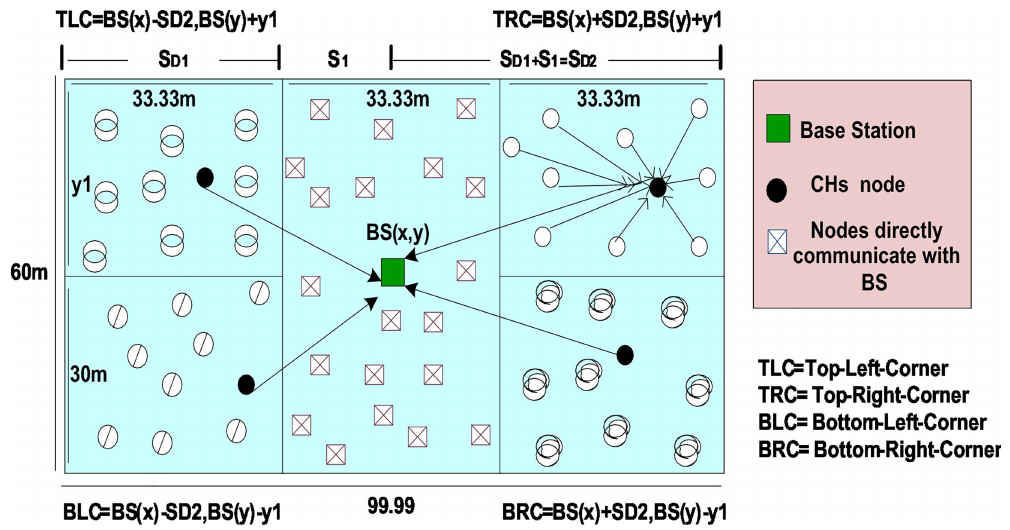
Fig 4. DISCPLNprotocolmodelin homogeneous and